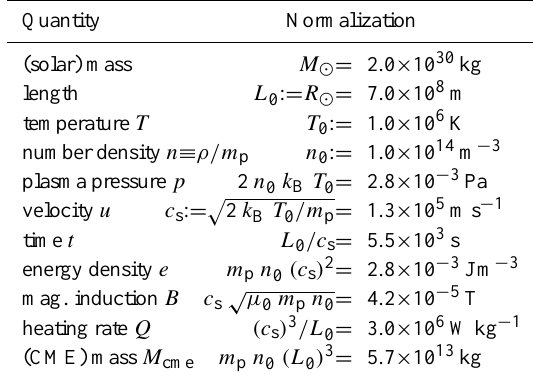
Table 1. Normalization constants used for Eqs. (1–4). M (cid:12) , R (cid:12) , k B , m p , µ 0 , and c s denote the solar mass, the solar radius, the Boltz- mann constant, the proton rest mass, the permeability of free space, and the isothermal sound speed,